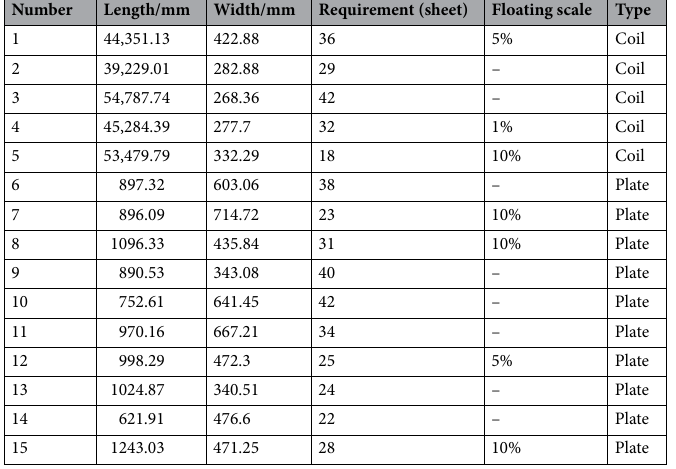
Table 1. Information of different kinds of products.